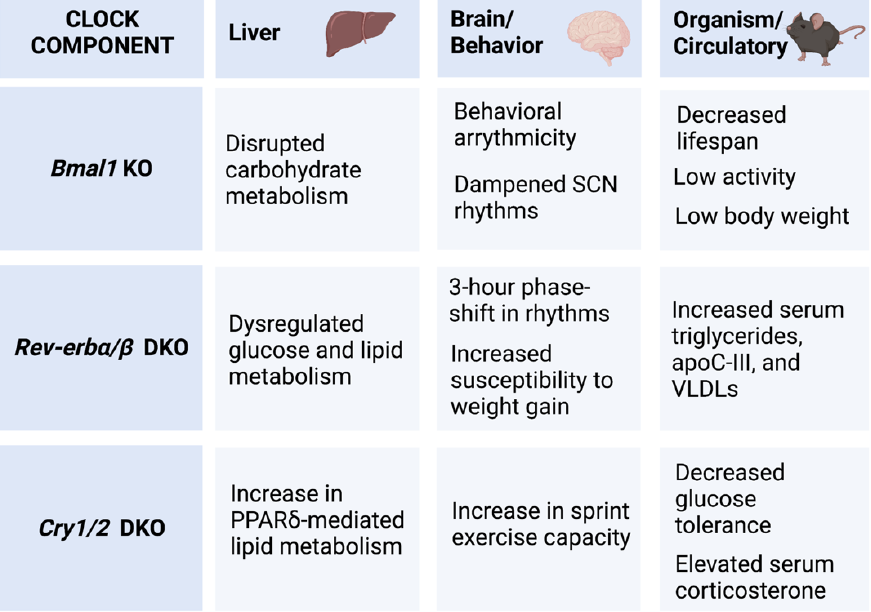
Figure 3. Select Effects of Molecular Clock Knockouts. Examples of select metabolic effects arising from molecular clock knockouts. Created with BioRender.com (accessed on 28 June 2022).